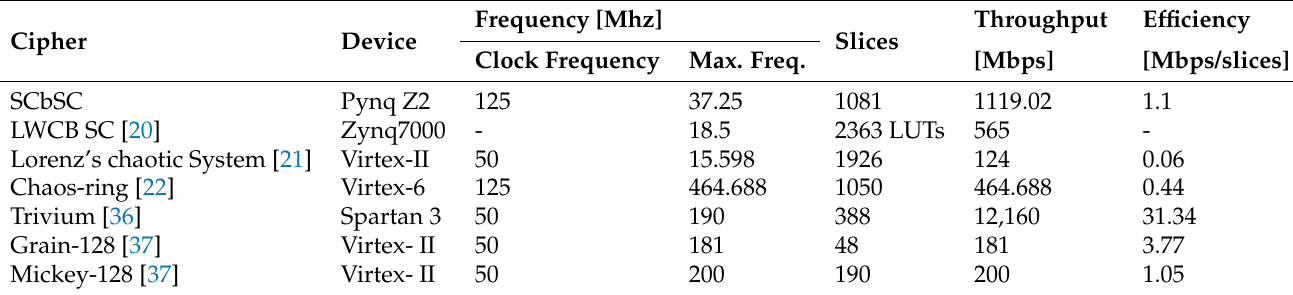
Table 5. Hardware metrics usage comparison of several chaotic and non-chaotic